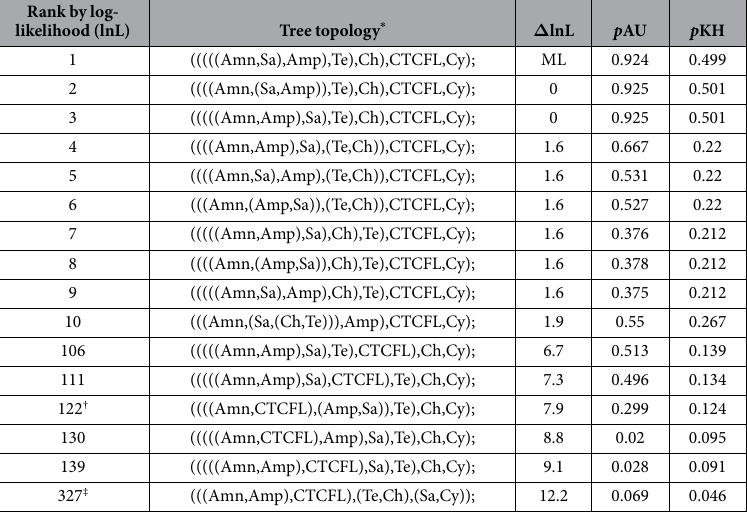
Table 2. Tree topology test for the duplication timing between CTCF and CTCFL . * Amn, amniote CTCF; Amp, amphibian CTCF; Sa, sarcopterygian CTCF; Te, teleost CTCF; Ch, chondrichthyan CTCF; Cy, cyclostome CTCF. † The phylogenetic tree supporting an amniote CTCF-CTCFL monophyly with the highest p AU. ‡ The phylogenetic tree supporting a tetrapod CTCF-CTCFL monophyly with the highest p AU. Abbreviation: ML, maximum likelihood